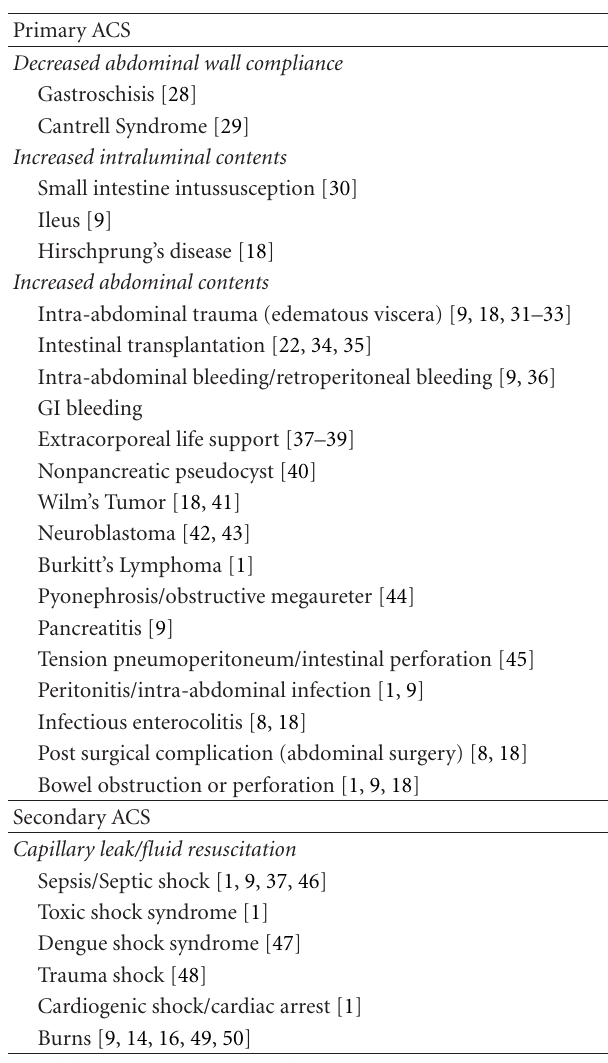
Table 3: Reported conditions associated with ACS in